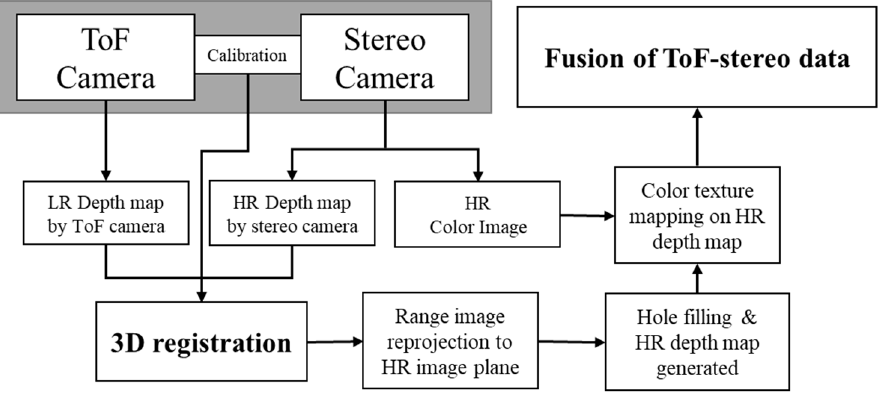
Figure 1. Overall procedure of the proposed method.